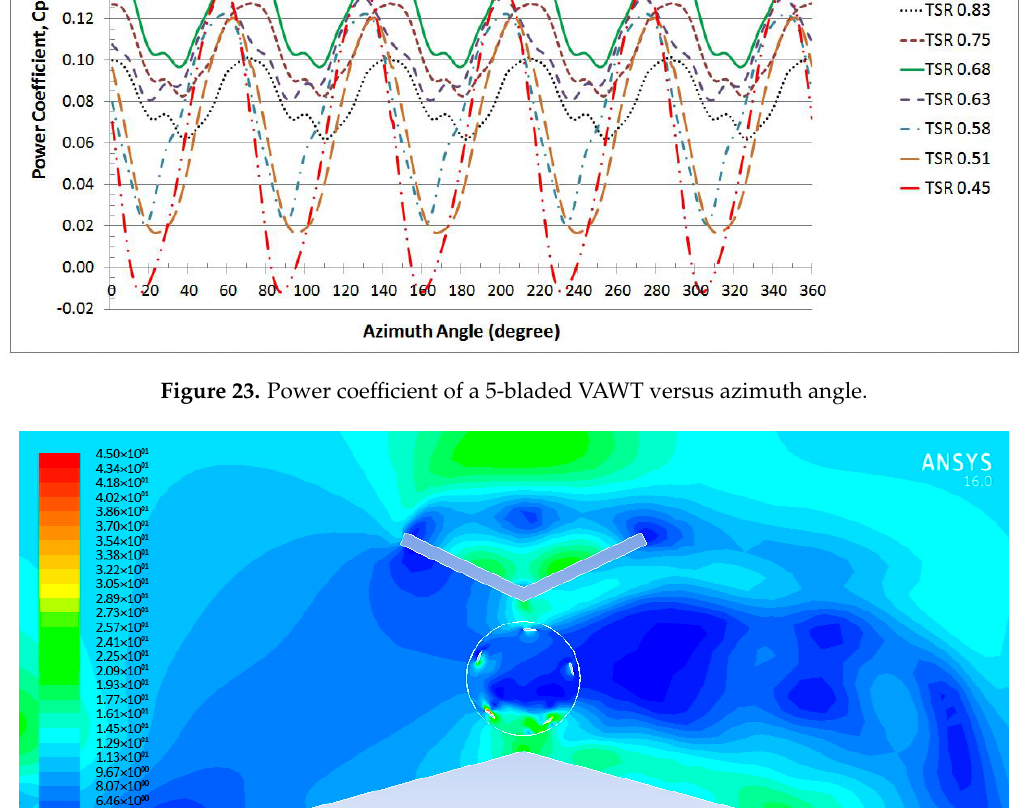
Figure 24. Flow vector visualization for a 5-bladed VAWT with the VRGV.